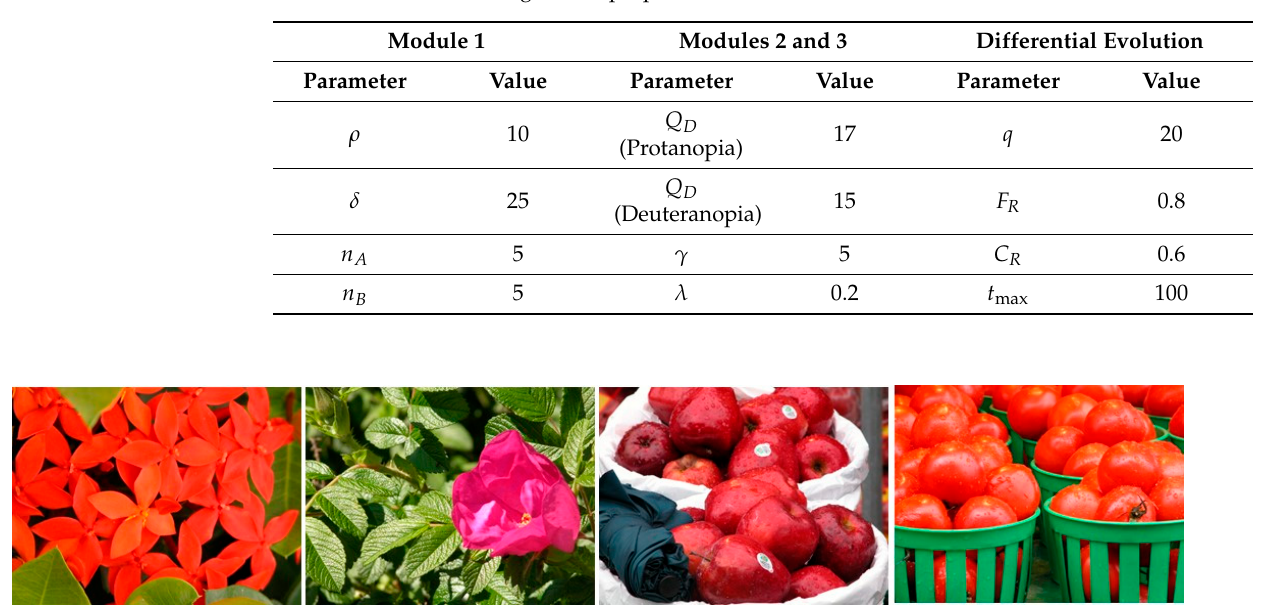
Table 1. Parameter setting for the proposed method.